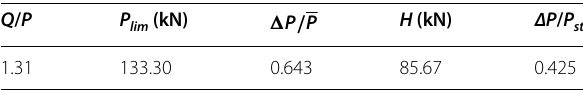
Table 6 Safety metrics of benchmark